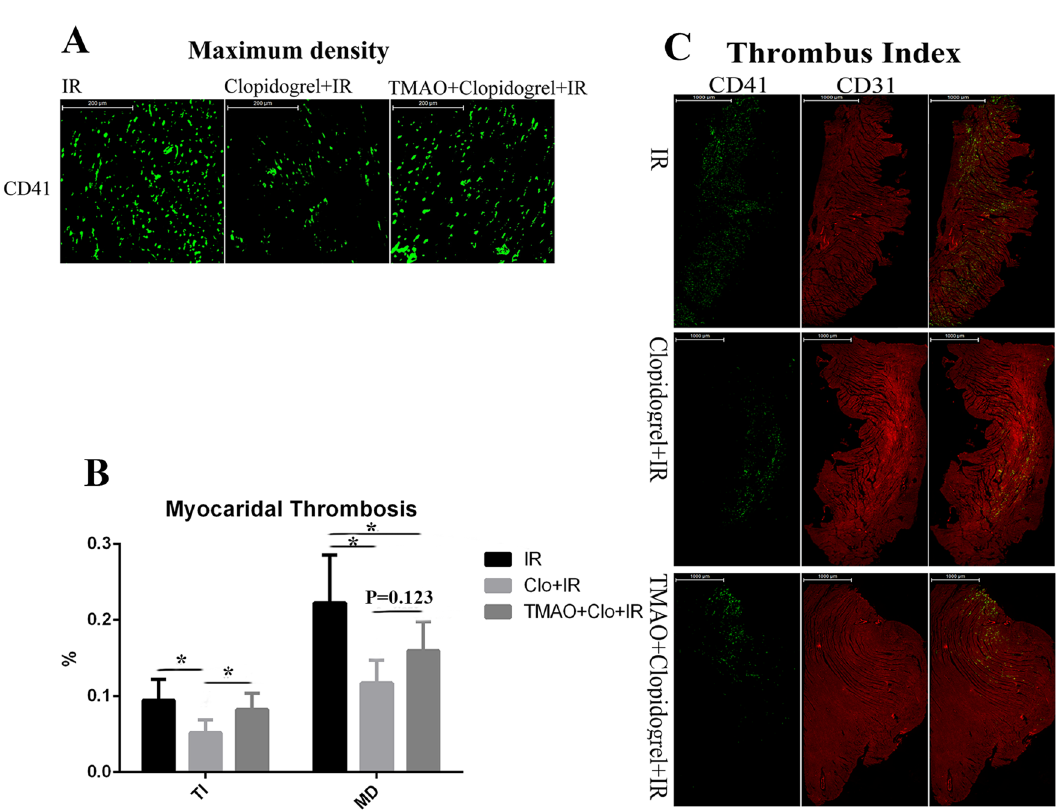
Figure 4. Clopidogrel reduced the myocardial thrombus burden and maximum density; TMAO partially increased the MD. * P <